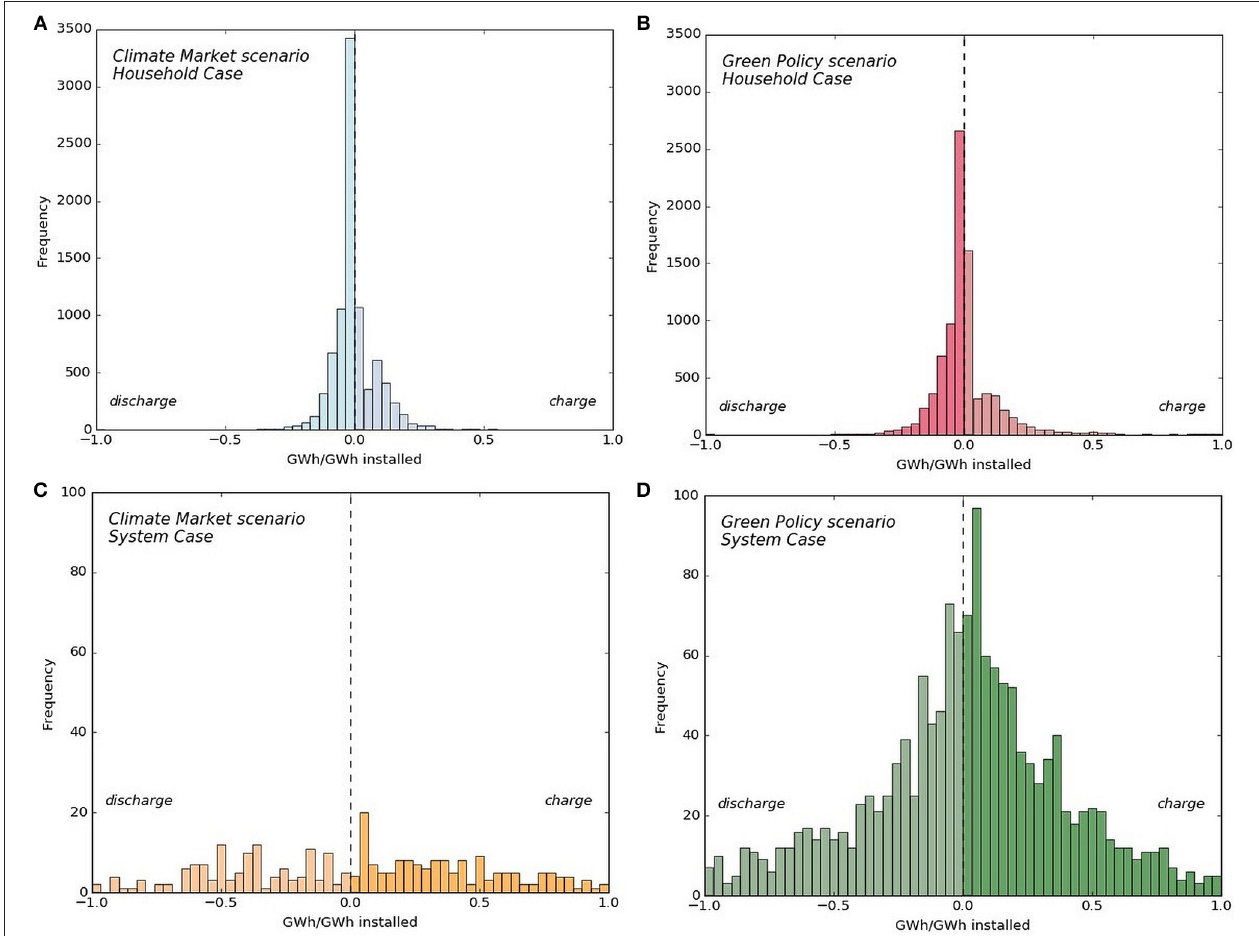
FIGURE 10 | Frequencies of charge and discharge events for region SE1 in the Climate Market scenario (flatter price curve) for (A) the Household case and (C) the System case, and in the Green Policy scenario (higher variability of the price curve) for (B) the Household case, and (D) the System case. For better readability the Household cases in (A,B) are plotted with a different scale on the y-axis than the System cases in (C,D)